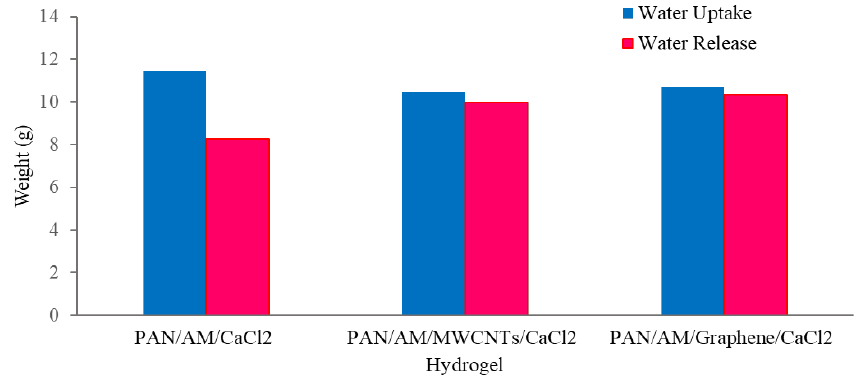
Figure 9. Atmospheric water collection using hydrogel with a magnifying glass.